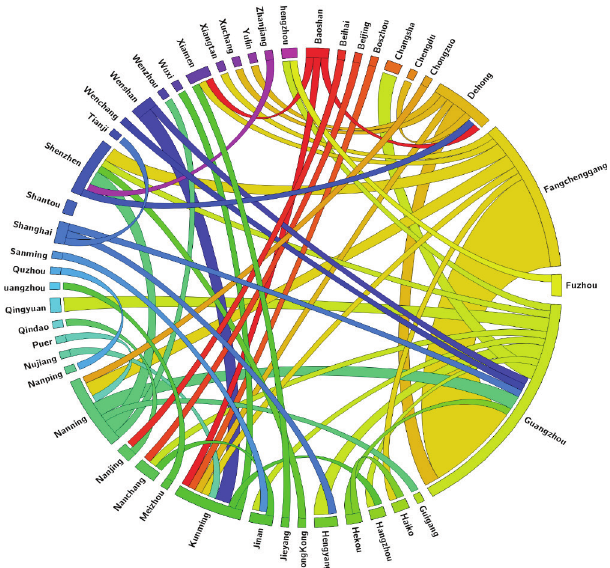
Figure 3. Circular graph visualization of intercities social network interaction of pangolins seizure inci- dent reports.